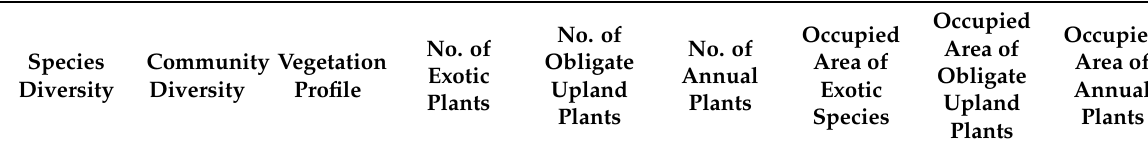
Table 3. Correlations (Pearson) between ten vegetation components, including a synthetic index obtained from combining the naturalness and weighted values of each vegetation